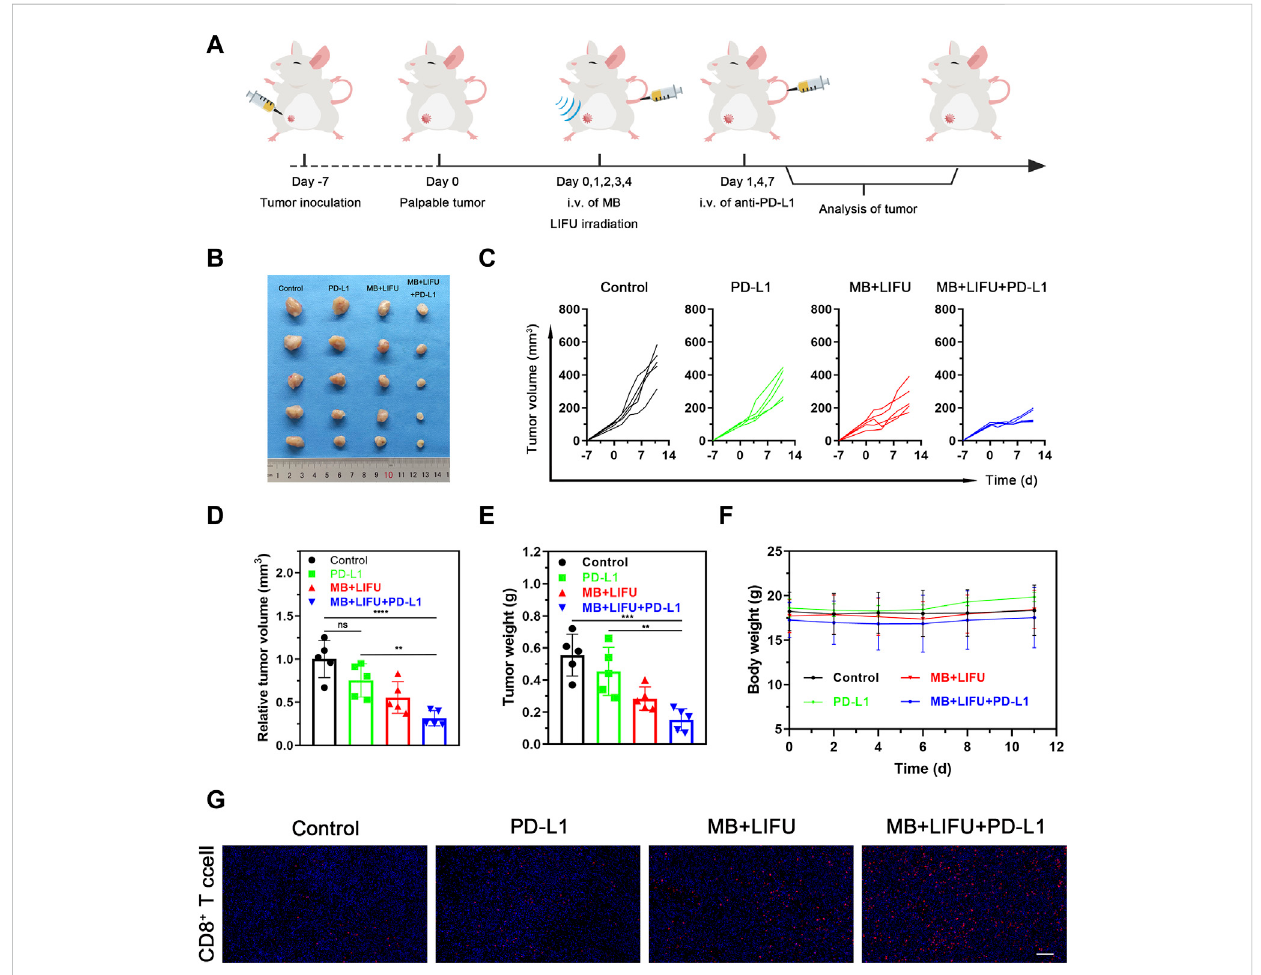
Evaluations of anti-tumor ef fi cacy in vivo of LIFU-TMD treatment plus PD-L1 blockade. (A) Schematic illustration of LIFU-TMD treatment plus anti- PD-L1 antibodies to suppress the development of the tumors. ( n = 5) (B) Representative tumor images of the 4T1 tumors of variousgroups after different treatments. Individual tumor growth curves (C) , the relative tumor volume (D) and tumor weights (E) of the 4T1 tumors after different treatments ( n = 5). (F) Body weight change in each group ( n = 5). (G) Immuno fl uorescence staining images of CD8 + T cell the 4T1 tumors. Scale bar: 100 μ m. Data